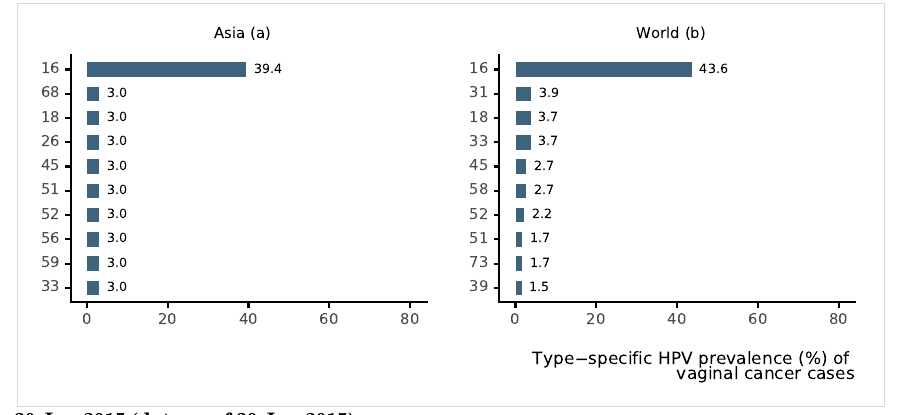
Figure 66: Comparison of the ten most frequent HPV types in cases of vaginal cancer in Asia and the World